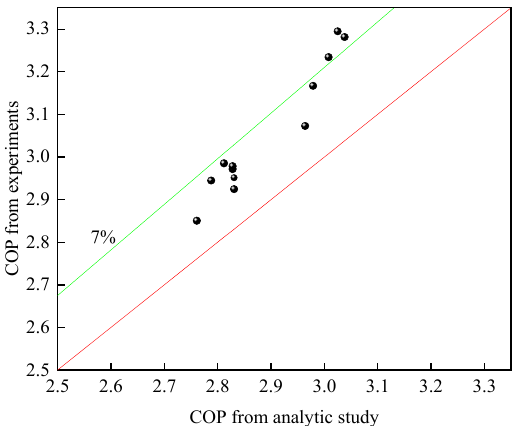
Figure 2. Comparison between COP obtained from thermodynamic analysis model and those from experiment.